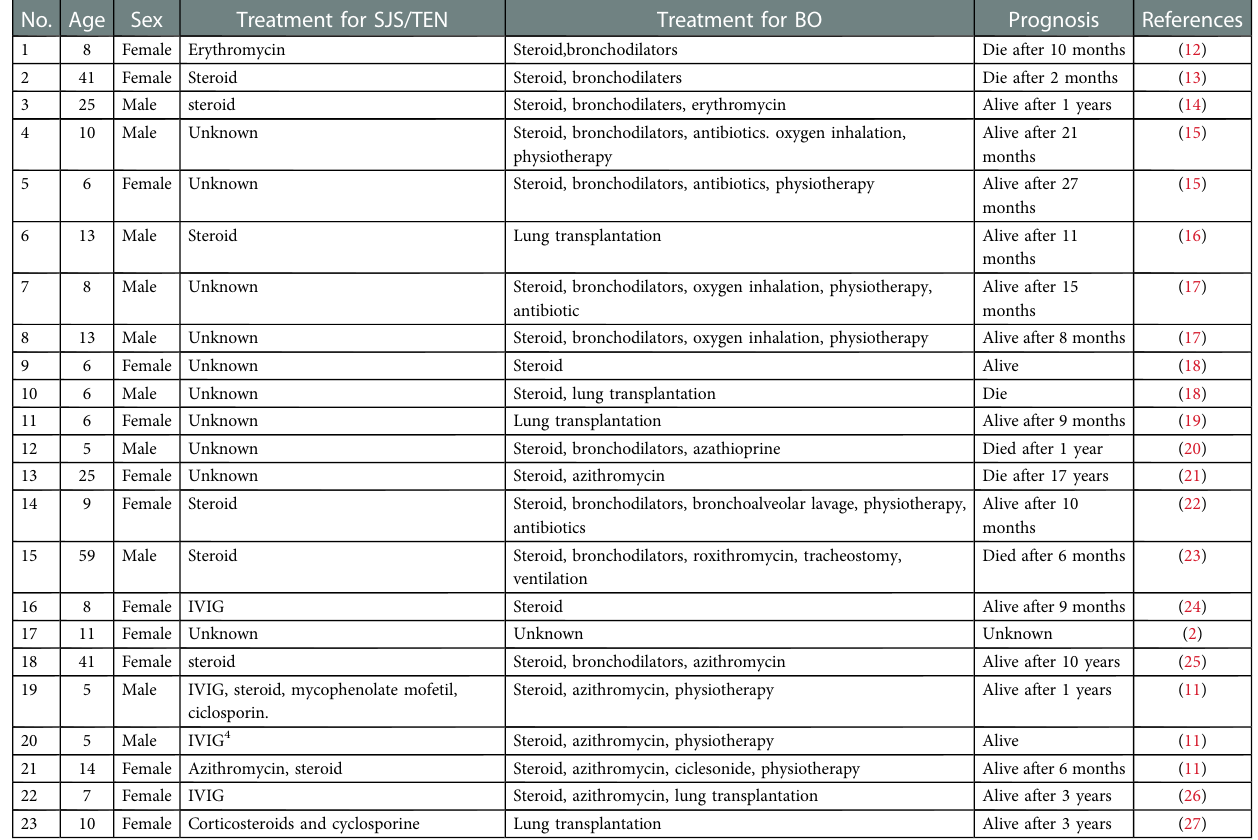
TABLE 2 Summary of treatment and prognosis in BO 1 associated with SJS 2 /TEN 3 from the published cases. No. Age